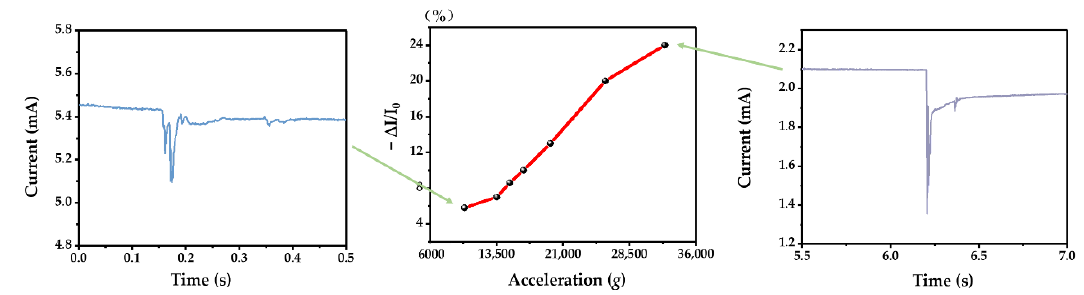
Figure 17. The current response changes according to acceleration increases.